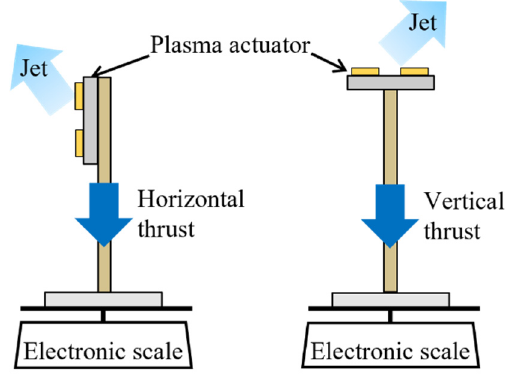
Figure 6. Setup for thrust measurement.